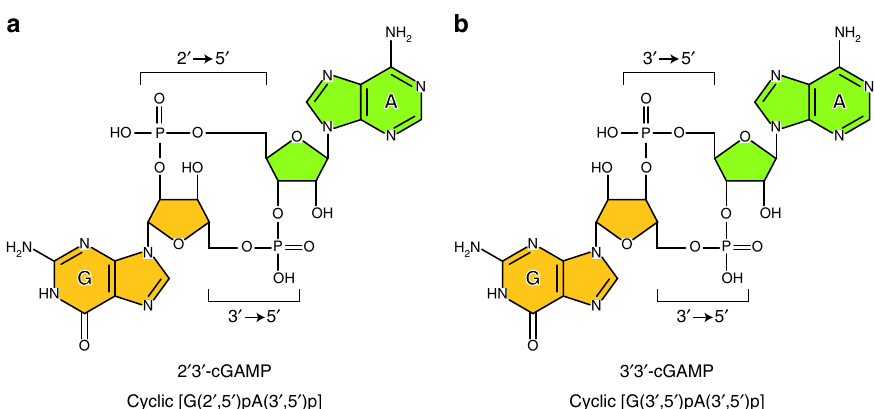
Fig. 1 cGAMP isomer structures. a , b Chemical structures of 2 ′ 3 ′ -cGAMP, cyclic [G(2 ′ ,5 ′ )pA(3 ′ ,5 ′ )p] ( a ) and 3 ′ 3 ′ -cGAMP, cyclic [G(3 ′ ,5 ′ )pA(3 ′ ,5 ′ )p] ( b ). 2 ′ 3 ′ -cGAMP contains the non-canonical 2 ′ -5 ′ and the canonical 3 ′ -5 ′ phosphodiester linkages, while 3 ′ 3 ′ -cGAMP contains the two canonical 3 ′ -5